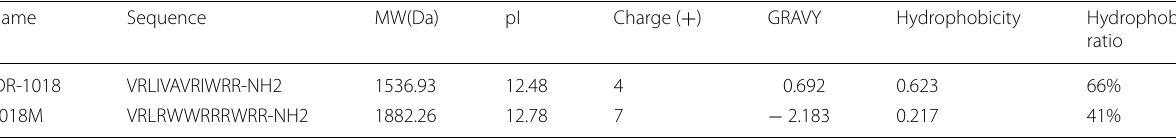
Table 1 The sequences and physicochemical parameters of IDR-1018 and 1018M